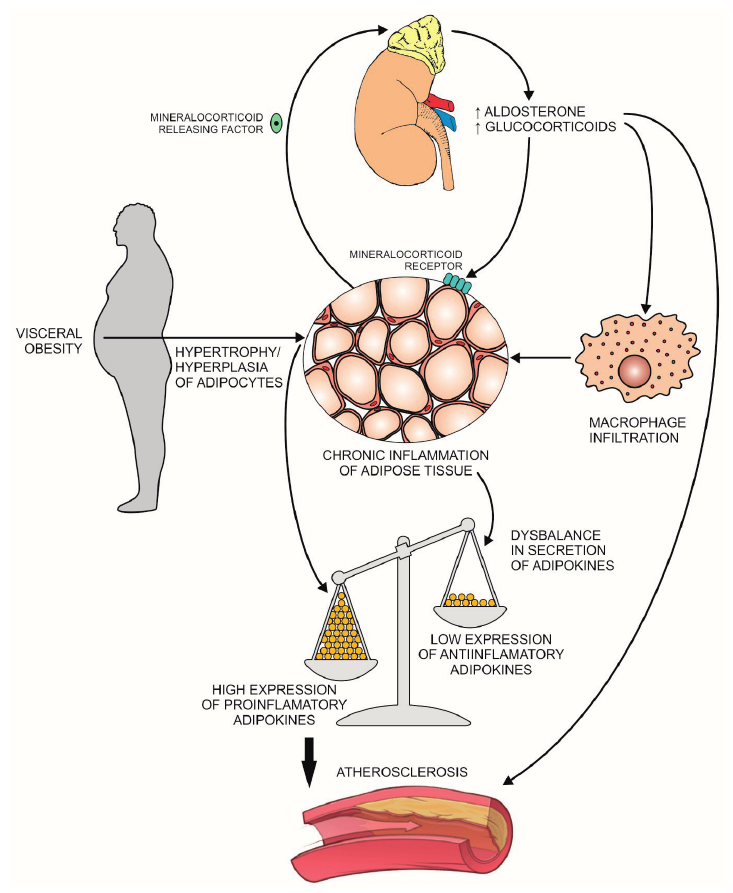
Fig. 1. Pathopysiological connections between adipose tissue, adipokines, renin-angiotensin system and